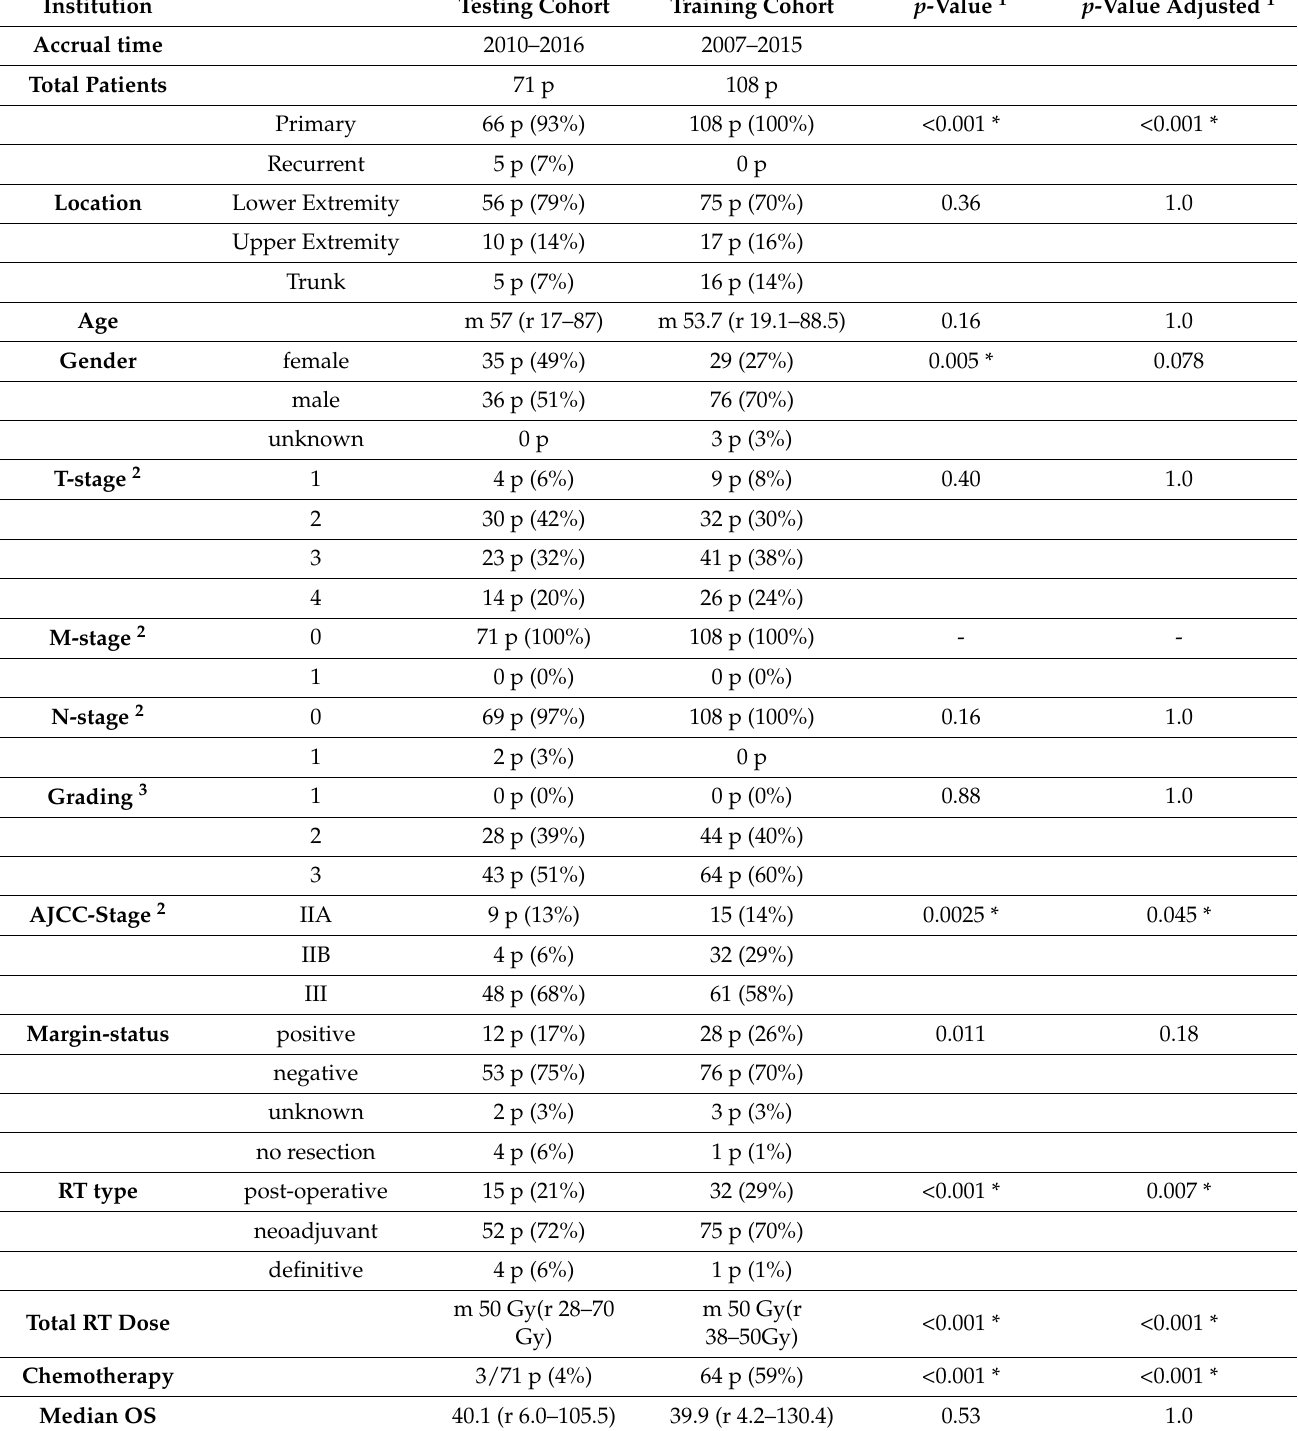
Table 2. Patient demographics, outcomes, and treatment